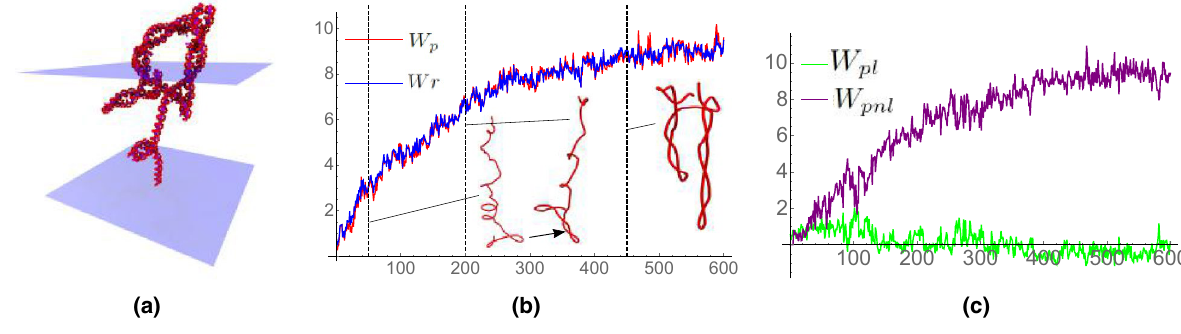
Figure 8. Results from simulations of an Lk = 80 DNA helix (over twisted) experiencing no extension force. In ( a ) we see the formation of significant supercoiling. In ( b ) we see that the development of this supercoiling is reflected by the steady increase in both writhing measures. Example axis curves from the time series are shown; they correspond to the times marked by the dashed vertical lines. The curves’ width/height ratios are 0.5, 0.4, 0.3 respectively and chosen for clarity (0.1 would be the actual ratio). ( c ) shows the local/non-local decomposition of W p . Except in the initial stage, the non-local writhing is dominant and increases over time as the curve forms increasing numbers of plectoneme type loops.